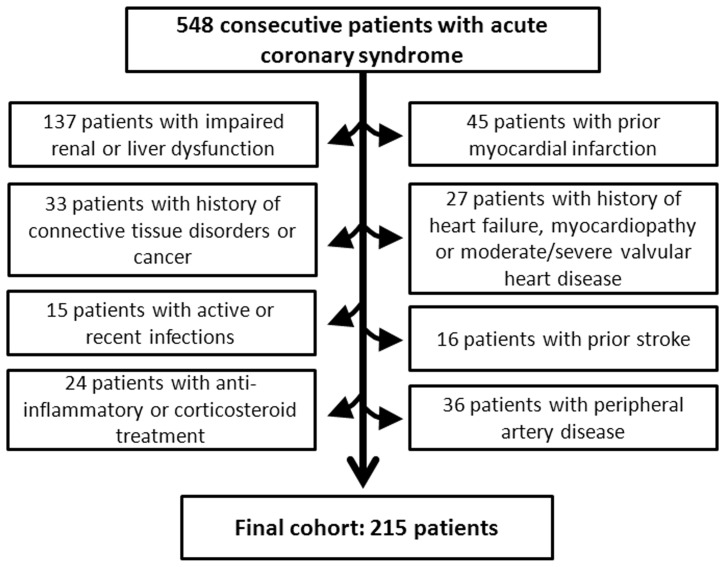
Consort diagram of the population included in the study.